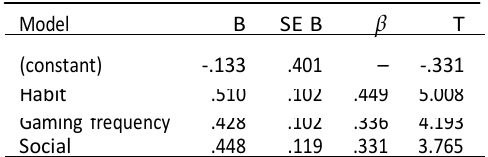
Table 3. Linear regression table for behavioral intention based